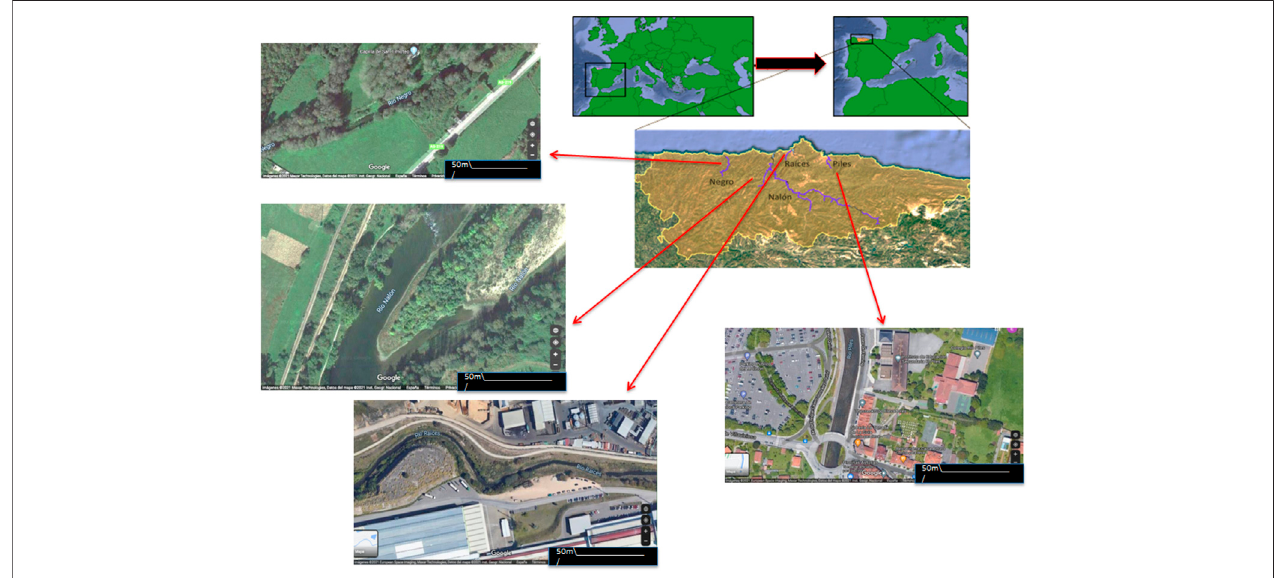
FIGURE1| Mapshowingthestudiedrivers.Arrowsshowscreenshotsonriverlowlands;bottombarsatrightineachimagerepresent50 m(source:GoogleMaps, Google ©2021).